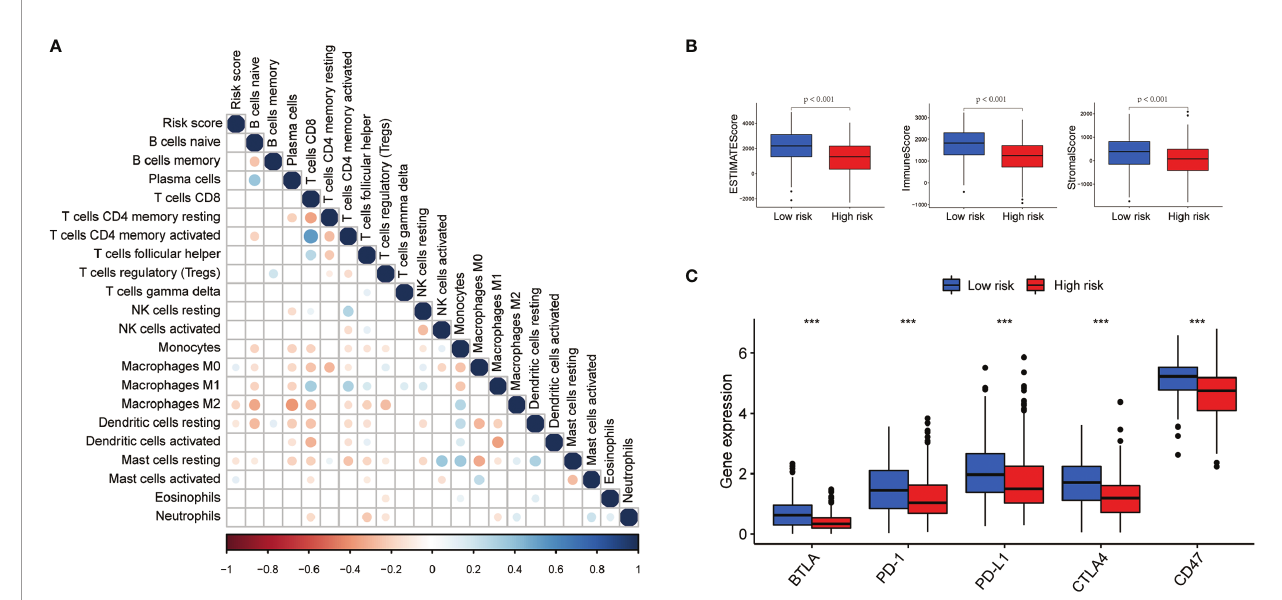
FIGURE 8 | Immune in fi ltration discrepancy in different risk groups. (A) The correlation of the risk scores and immune cells in fi ltration. (B, C) The differences of ESTIMATE scores and expression of fi ve common immune checkpoints in different risk groups ;***P <